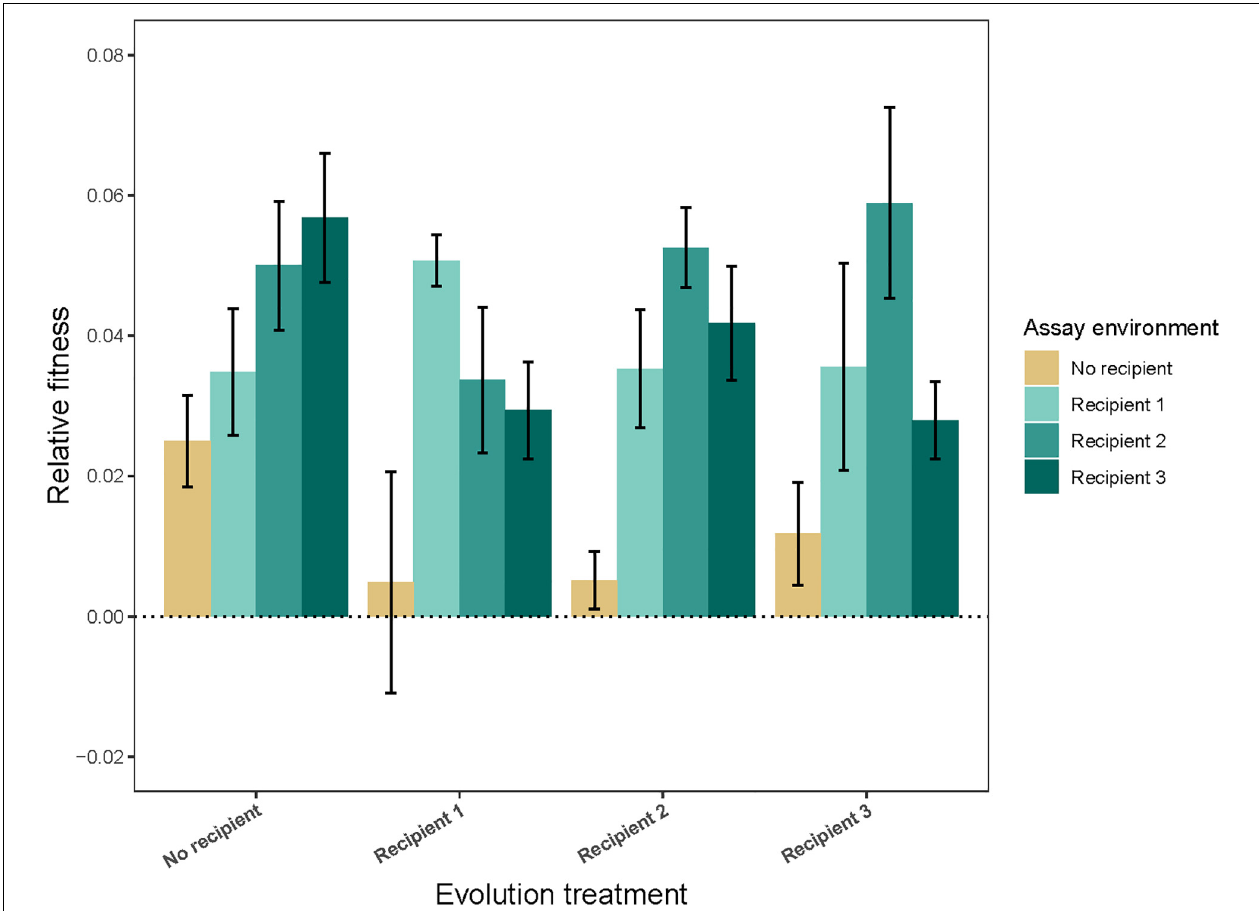
FIGURE 1 | Relative fitness ( ± 95% CI) of populations evolved in the absence ( No recipient ) or presence ( Recipient 1 , Recipient 2 , or Recipient 3 ) of a non-evolving recipient strain, assessed in different assay environments. Bars show the average of nine independently evolved populations that were each assayed using three